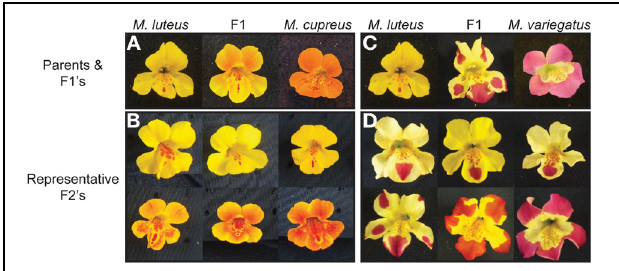
FIGURE 4 | Two trajectories for floral anthocyanin gains in the Chilean Mimulus . (A) M. luteus has yellow flowers with red anthocyanic spots in the throat, typical of other closely related species in the genus. M. cupreus has gained anthocyanin throughout the corolla, giving it a red-orange color. (B) F2’s from a cross between M. luteus and M. cupreus show that petal lobe anthocyanins segregate independently from variation in anthocyanic throat markings (Cooley and Willis, 2009). (C) M. variegatus is a second taxon that independently gained floral anthocyanins (Cooley et al., 2011). (D) Segregating variation in F2’s between M. luteus and M. variegatus suggests that variation in anthocyanins may occur via repatterning of the spot on the lower-middle petal. Extensive variation in size and shape of this marking is evident, including examples where expansion of spots cover the entire distal half of each petal. All photos provided by Arielle